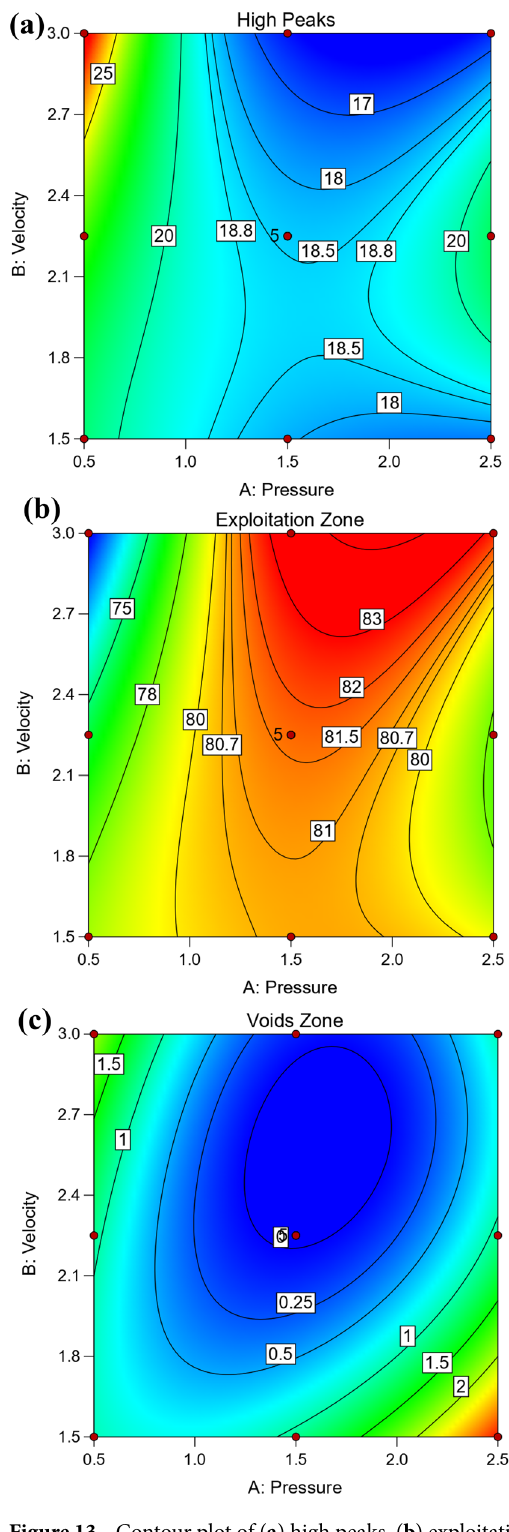
Figure 13. Contour plot of ( a ) high peaks, ( b ) exploitation and ( c ) voids zones of